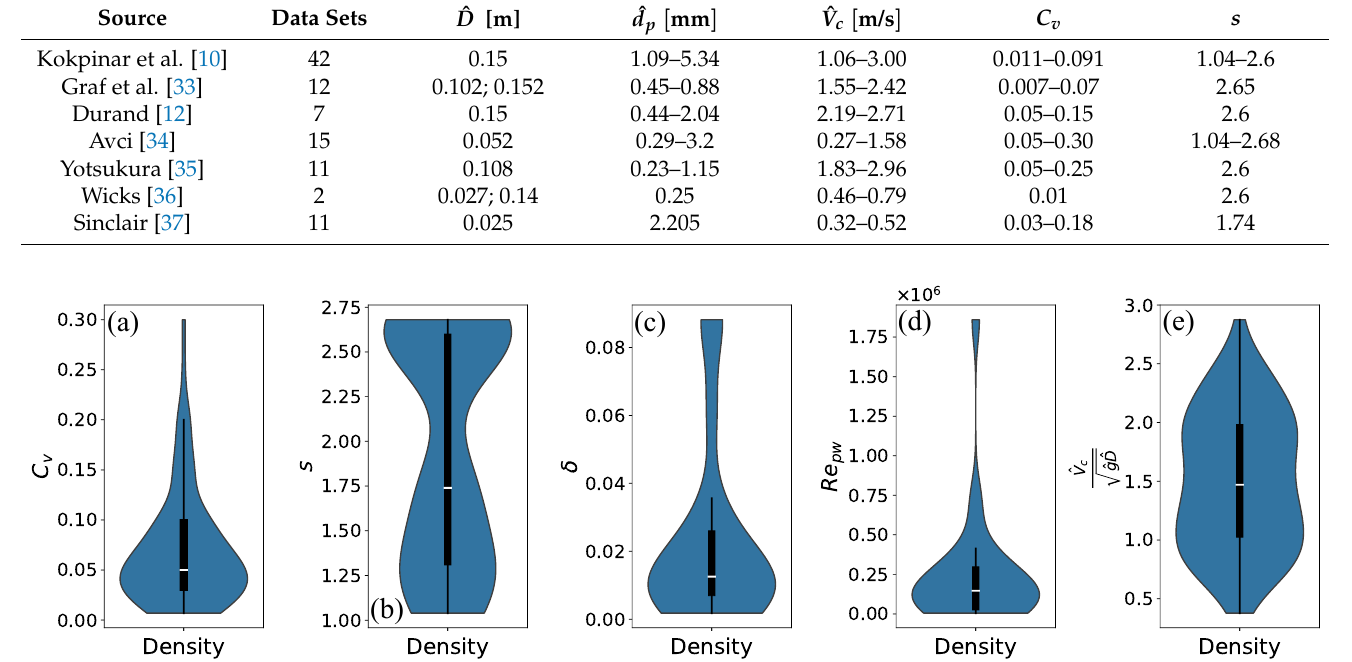
Table 2. Parameters of the experimental data considered for comparison with critical velocity.